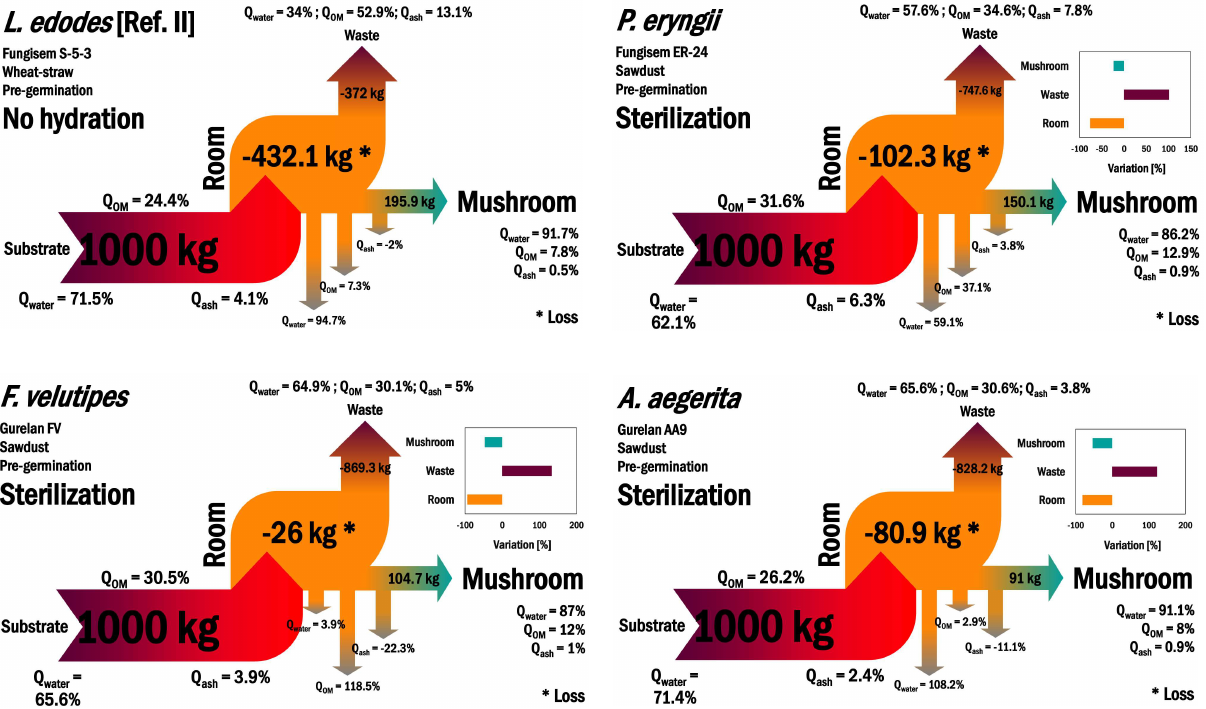
Figure 6. Comparative balance of mass through the systems producing exotic mushrooms. The sublevel bar-plot diagram displays the performance of exotic fungi relative to L. edodes . * Refers to a mass loss value in the production room.